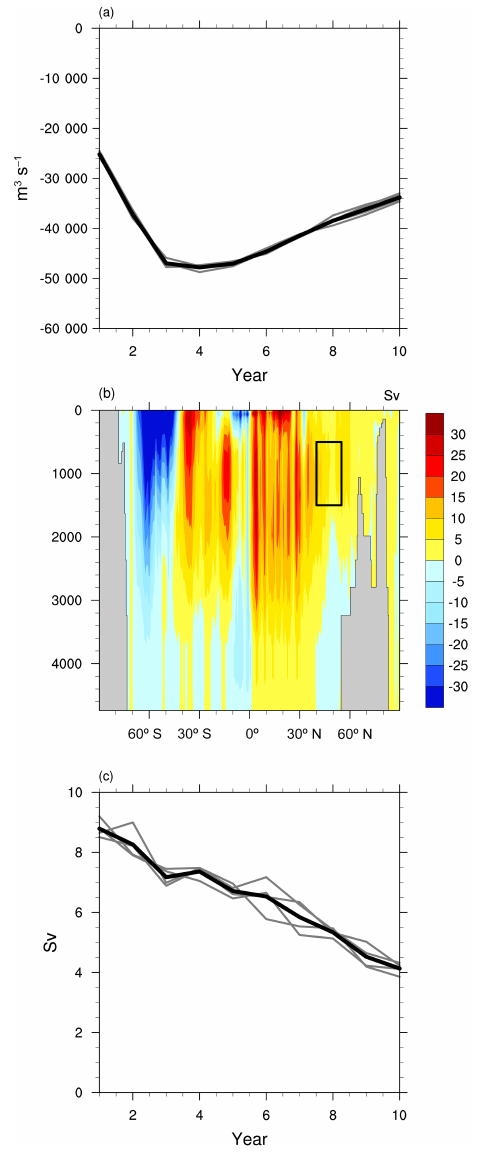
Figure 12. (a) Freshwater export through the Fram Strait (the cross section along 74 ◦ N and between 30 ◦ W and 10 ◦ E), (b) Atlantic Ocean Meridional Overturning stream function in September aver- aged for all decadal hindcasts from 1981 to 2015 for the CFSv2 and (c) time series of stream function averaged over 40–55 ◦ N, 500– 1500m as indicated by the black box in the middle panel. The thin gray line represents each ensemble member, and the thick black line represents the ensemble mean.